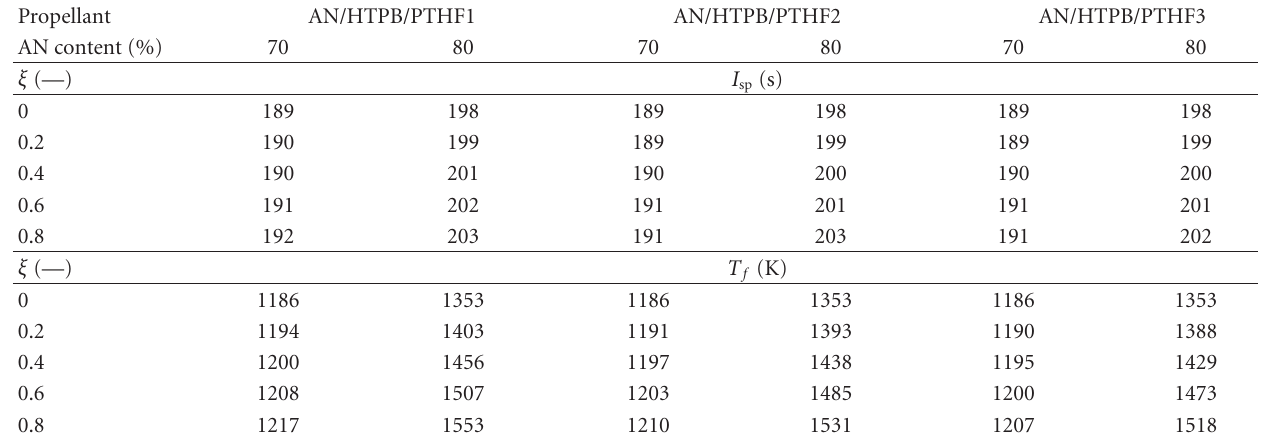
Table 3: Theoretical values of I sp and T f .